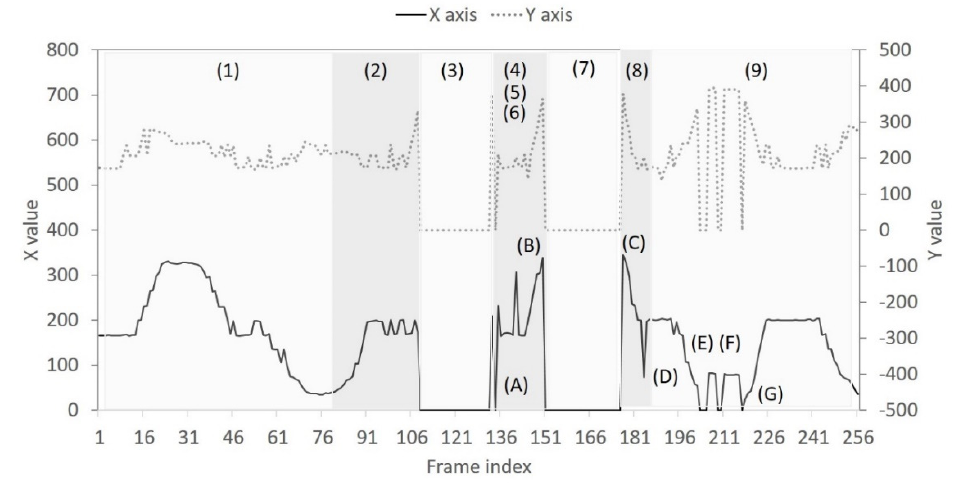
Figure 7. Real − time trace of XY coordinates for the bounding box from the vertical low angle: numbers (1)~(9) stand for different statuses; letters (A) and (E)~(G) represent detection failure events; letters (B)~(D) represent scene change events.